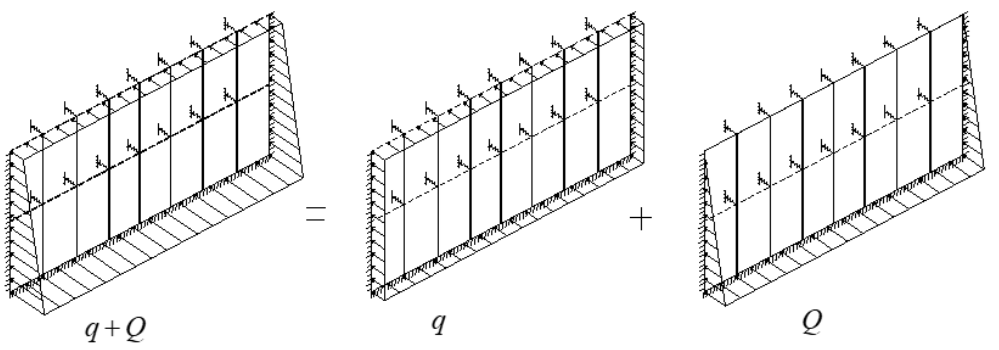
Figure 8. Simplified calculation model of wall column.